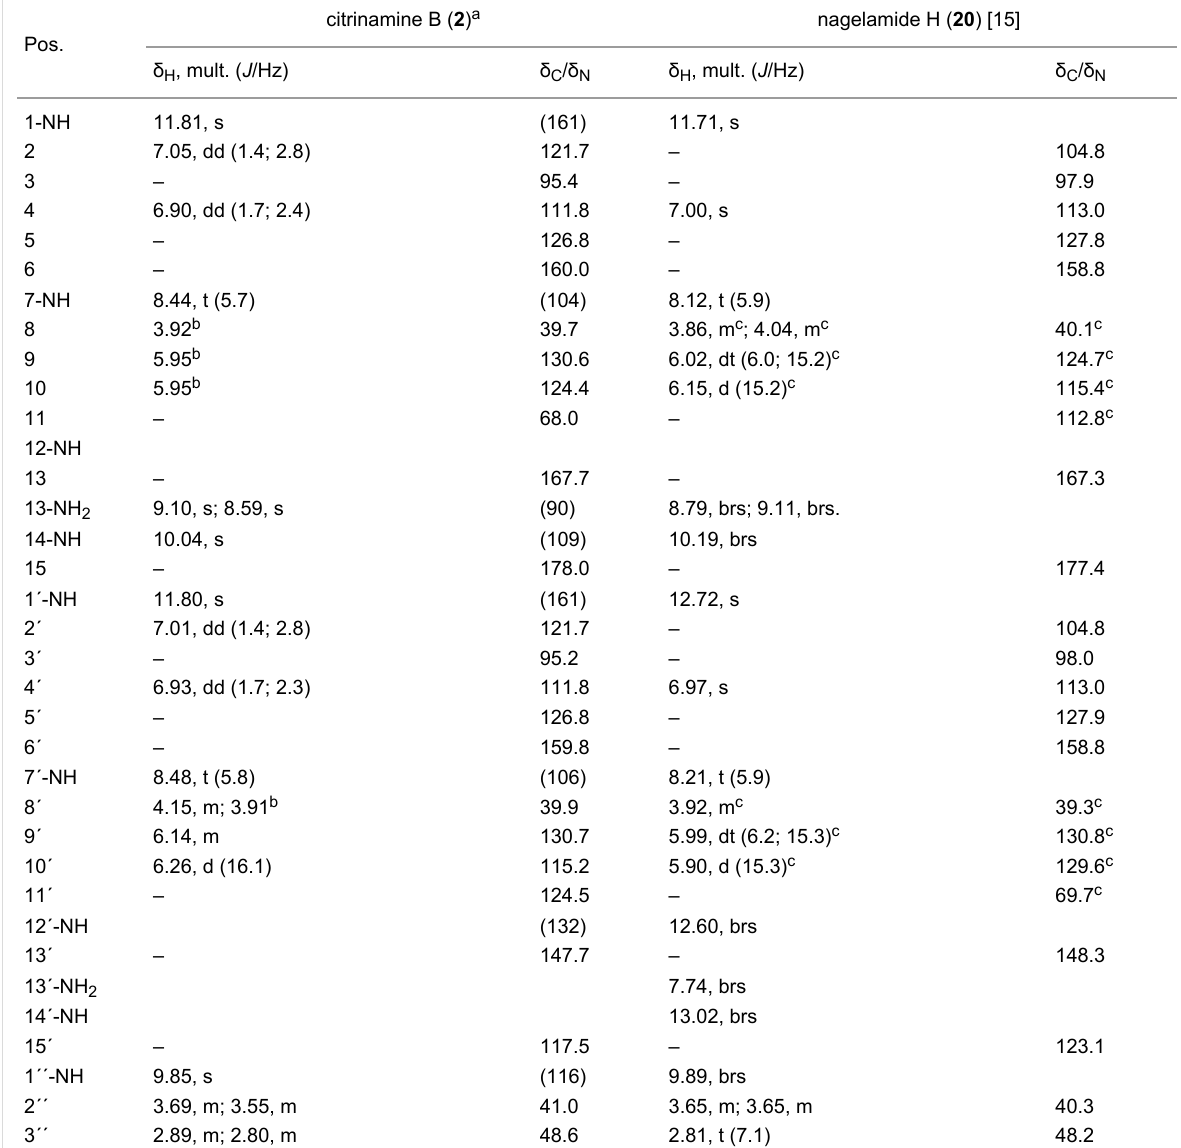
Table 2: 1 H, 13 C, and 15 N chemical shifts of citrinamine B ( 2 ) (600 and 850 MHz, DMSO- d 6 ) in comparison to nagelamide H ( 20 ) (600 MHz, DMSO- d 6